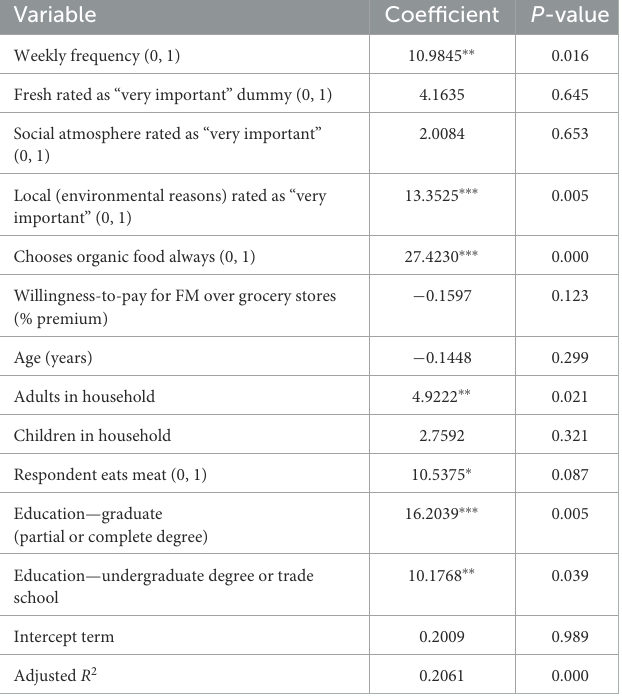
TABLE 3 OLS regression model of spending ($) as dependent variable, n = 200 + . Variable